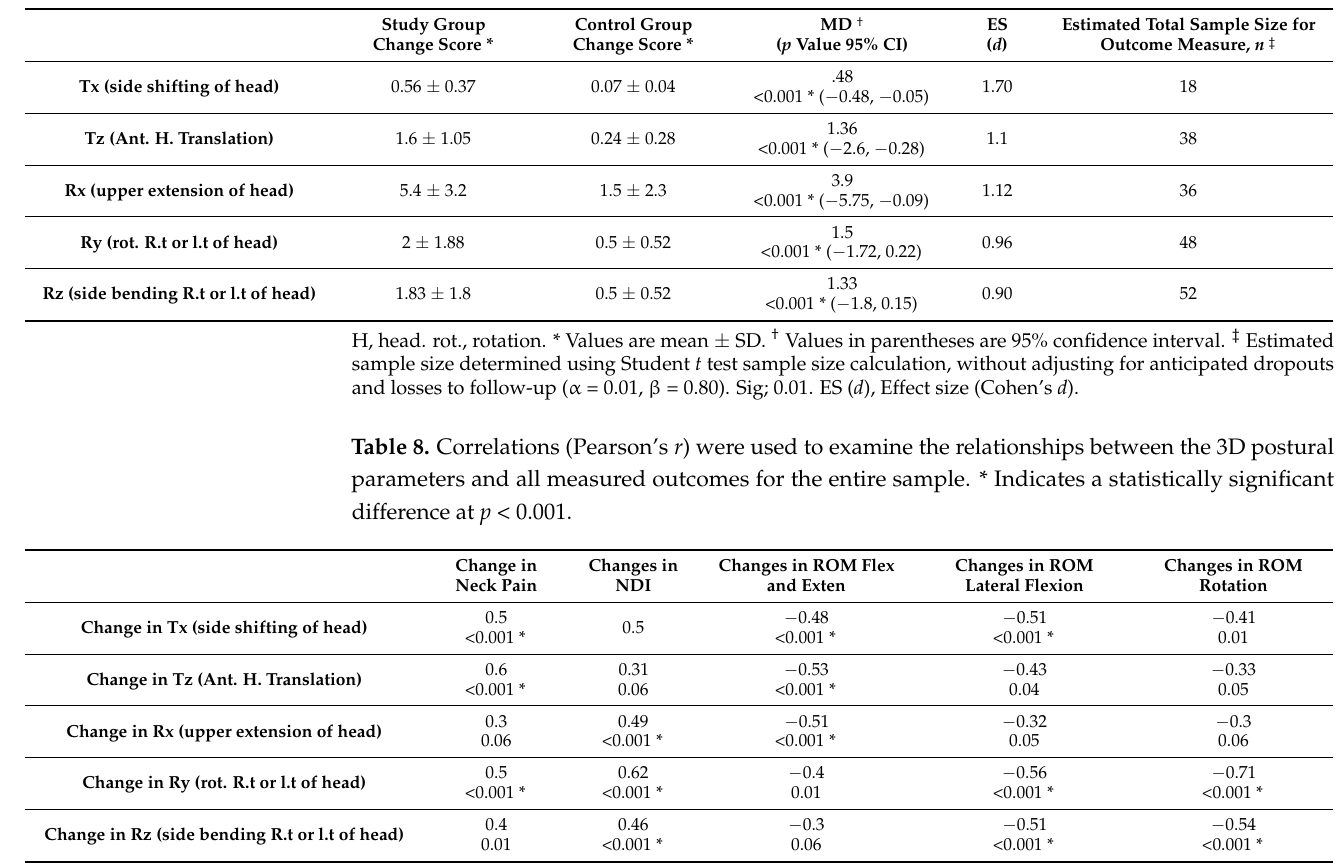
Table 7. Between-group differences in change scores, effect size, and estimated sample size for 3D posture parameters of head related to thoracic with significance level 0.01. Postural translations (Tx and Tz) are measured in centimeters and postural rotations (Rx, Ry, Rz) are measured in degrees. Study Group Change Score *